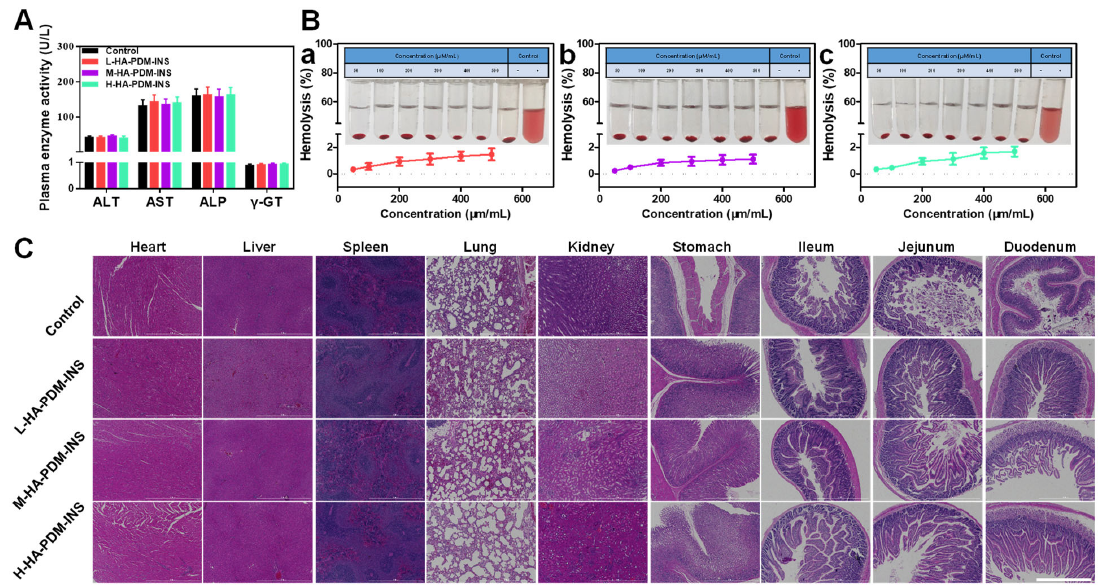
Figure 9. Safety. ( A ) Biomarkers of ALT, AST, ALP, and γ -GT from healthy rats after 7 d treatment with L-HA–PDM–INS, M-HA–PDM–INS, and H-HA–PDM–INS (X ± SD, n = 6). ( B ) Hemolysis assay with red blood cells exposed to L-HA–PDM–INS ( a ), M-HA–PDM–INS ( b ), and H-HA–PDM–INS ( c ) (X ± SD, n = 3). ( C ) H&E staining of the main organs (heart, liver, spleen, lung, kidney, and intestinal) harvested from different groups, scale = 1000 µ